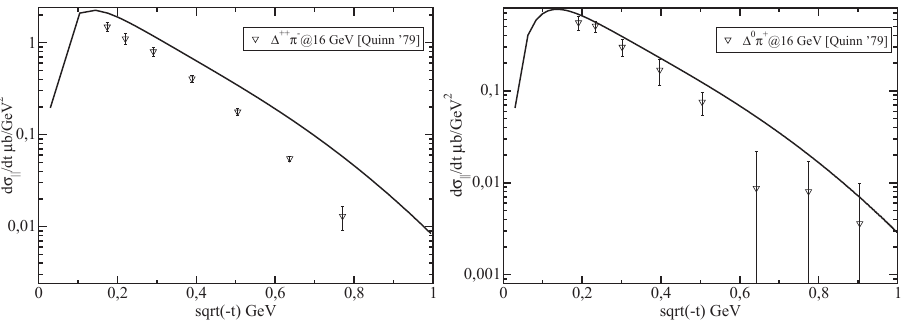
Figure 3. Cross sections for photons polarized parallel to the production plane calculated at E γ = 16